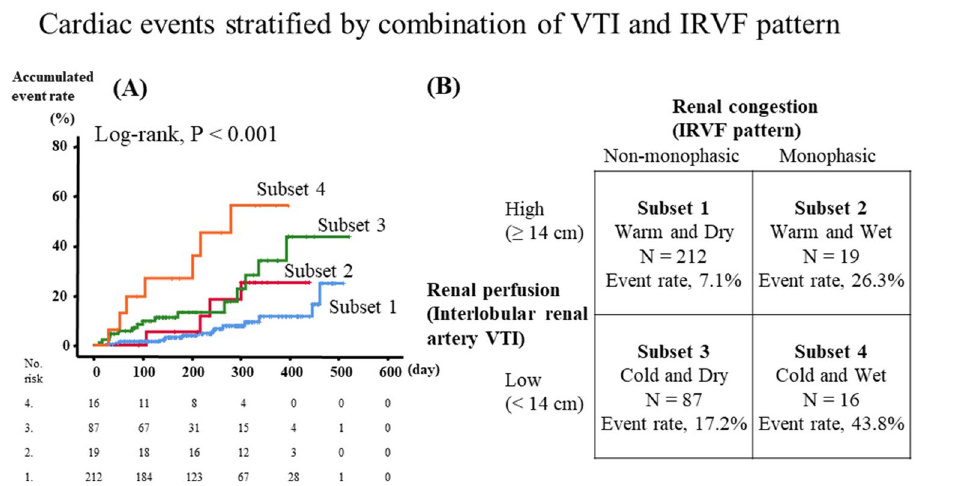
Figure 2. Cardiac events stratified by combination of VTI and IRVF pattern. VTI velocity time integral, IRVF intrarenal venous